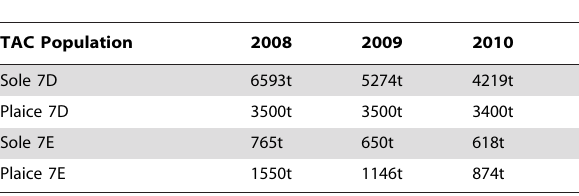
Table 2. TAC values used for the first three simulated